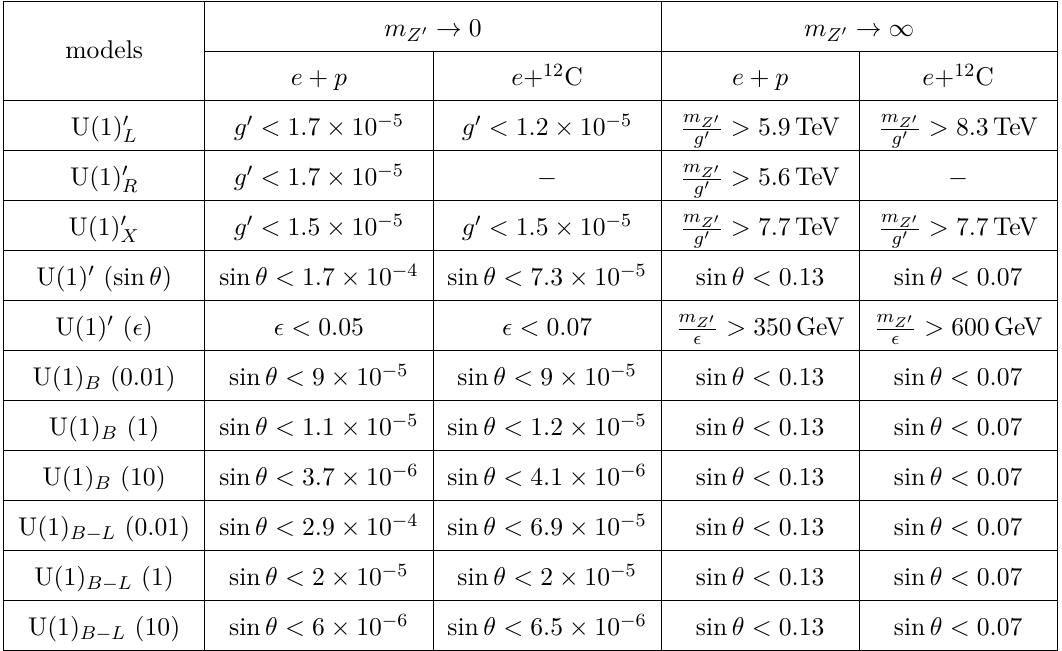
Table 3 . P2 sensitivities for the chiral and non-chiral models shown in figures 2 to 6 in the limits of m Z 0 → 0 and m Z 0 → ∞ . “ U(1) ( sin θ , (cid:15) )” refers to the generic U(1) 0 model with only mass mixing sin θ or kinetic mixing (cid:15) . The numbers in the parentheses for the U(1) the values of g 0 / sin θ . Note that for the U(1) 0 mode due to an accidental cancellation (cf. eq.